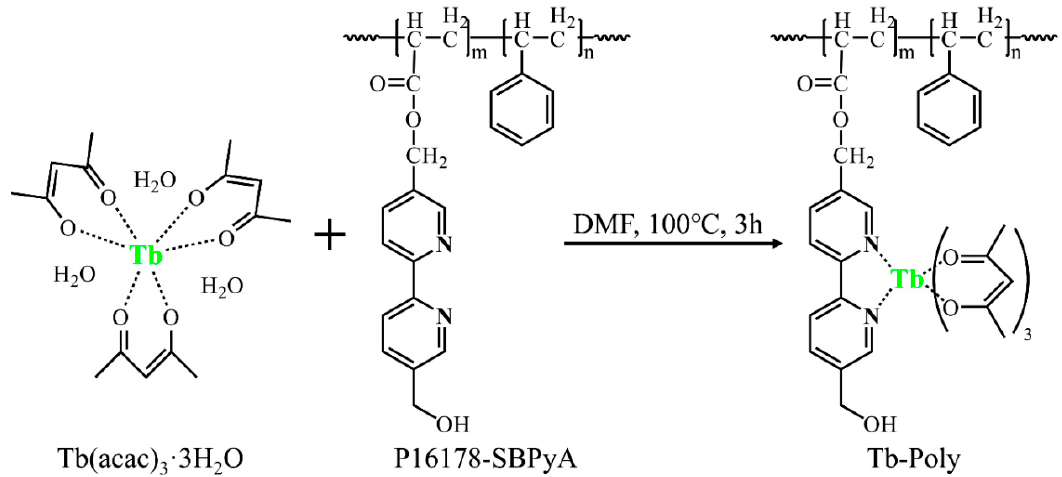
Figure 1. Schematic illustration of the synthesis of Tb-containing metallopolymer (Tb-Poly).